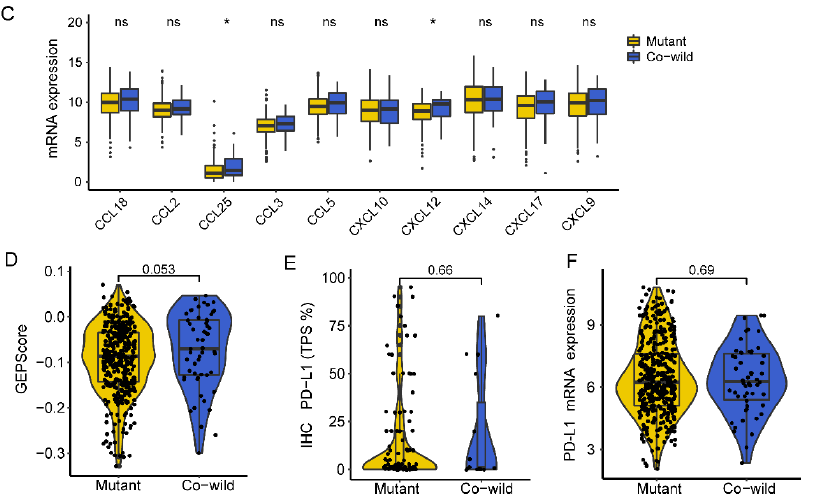
Figure 6. The tumor immune microenvironments of TP53 / LRP1B mutant and co-wild LUSC. ( A ) The results of ssGSEA for TP53/LRP1B mutant and co-wild LUSC. ( B ) The difference of antigen presentation related gene expression between TP53/LRP1B mutant and co-wild LUSC. ( C ) The differ- ence of chemokine-related genes expression between TP53/LRP1B mutant and co-wild LUSC. ( D ) The GEP-score difference between TP53/LRP1B mutant and co-wild LUSC. ( E ) The IHC PD-L1 expression difference between TP53/LRP1B mutant and co-wild LUSC in the Geneplus cohort. ( F ) The PD-L1 mRNA expression difference between TP53 / LRP1B mutant and co-wild LUSC in the TCGA cohort. * Adjust- p <